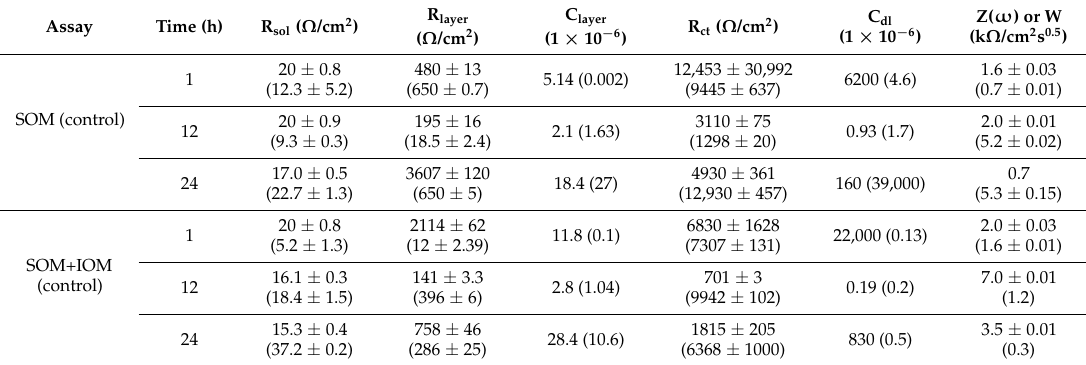
Table 1. Electrochemical impedance spectroscopy (EIS) parameters after adjusting the equivalent circuits for biotic assays of SOM or SOM+IOM interaction with MCE*-S 0 and their corresponding abiotic control. Data: Average ( n = 3) ± standard